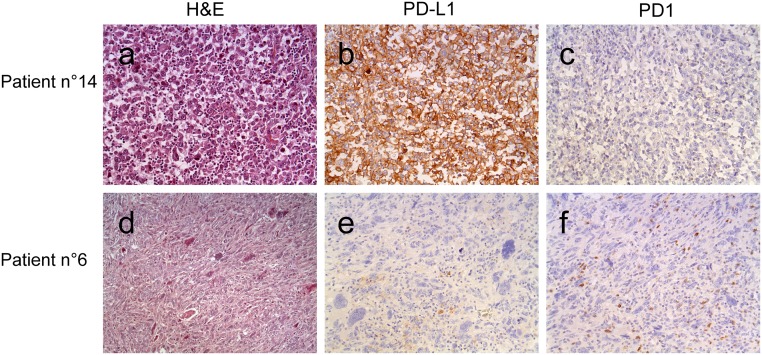
Microphotograph of 2 cases, at x200 magnification for H&E and immunohistochemistry.Patient 14 was frankly positive with rare PD1 positive TILs. Patient 6 was negative for PD-L1, rare immune cells stained serving as an internal control. PD1 positive TILs were present within the tumor.